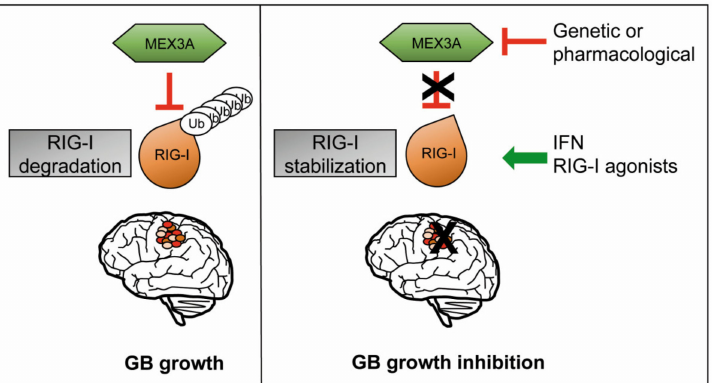
Figure 7. A representative model showing the role of MEX3A and RIG-I in GB tumorigenesis. RNA-binding ubiquitin ligase MEX3A ubiquitylates and induces the proteasome degradation of RIG-I, thus favoring GB growth. On the other hand, genetic depletion of MEX3A results in the increase of RIG-I protein levels impairing GB proliferation. The inhibition of MEX3A and / or the activation of RIG-I could represent promising multi-targeting strategies for GB